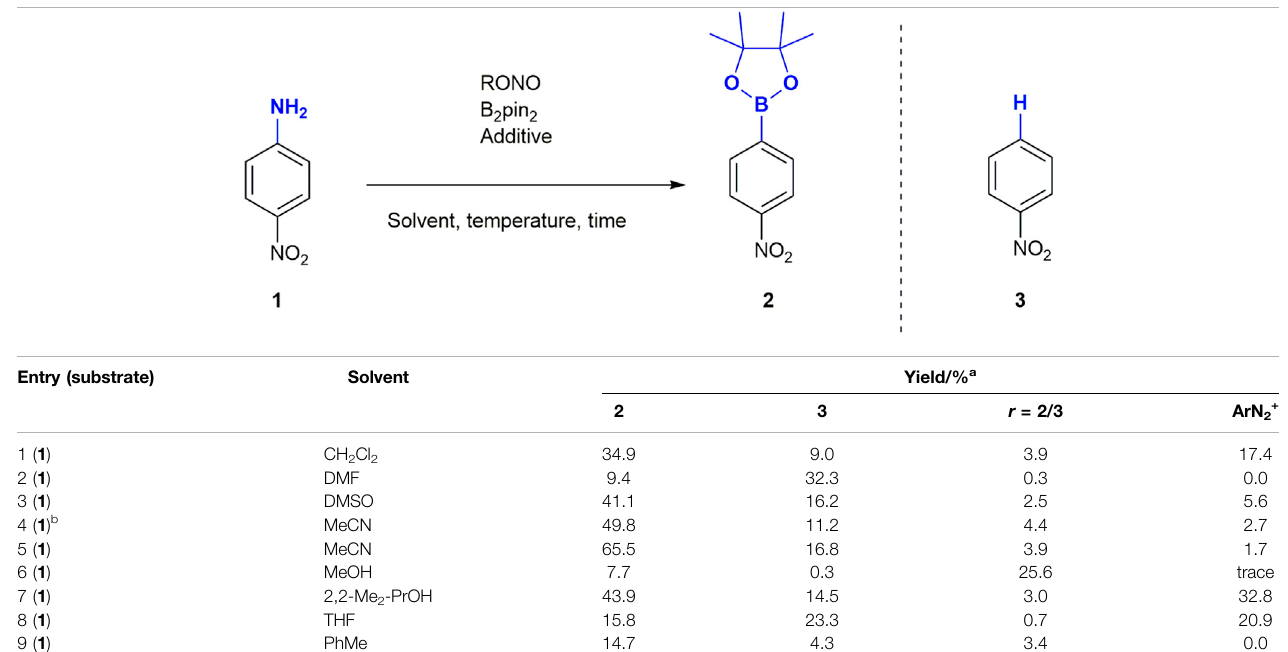
TABLE 1 | Effect of solvent on the formation of